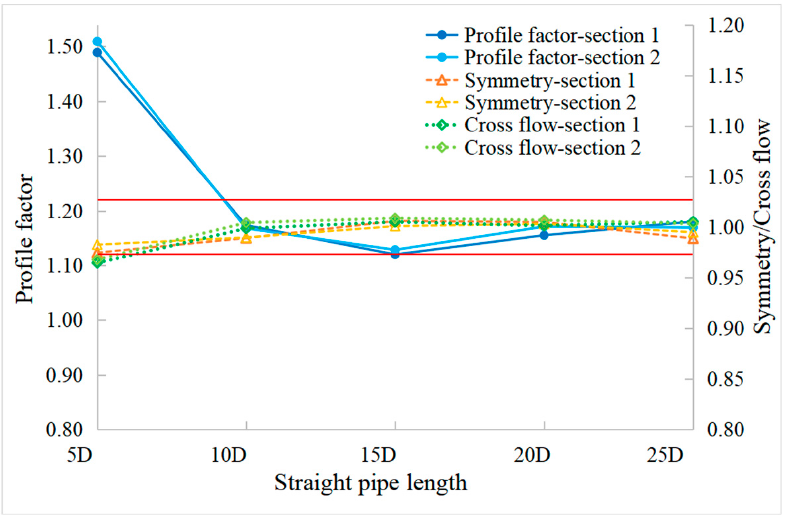
Figure 18. Characteristic parameters with FC.